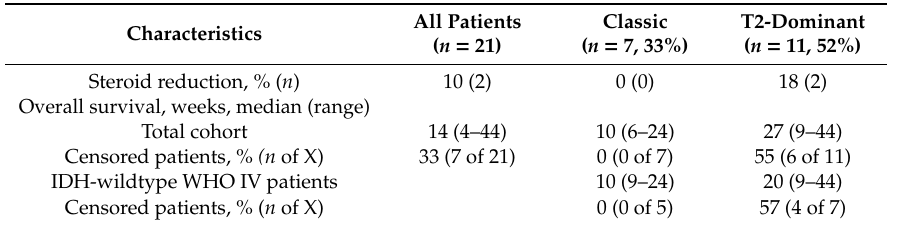
Table 3. Regorafenib e ffi